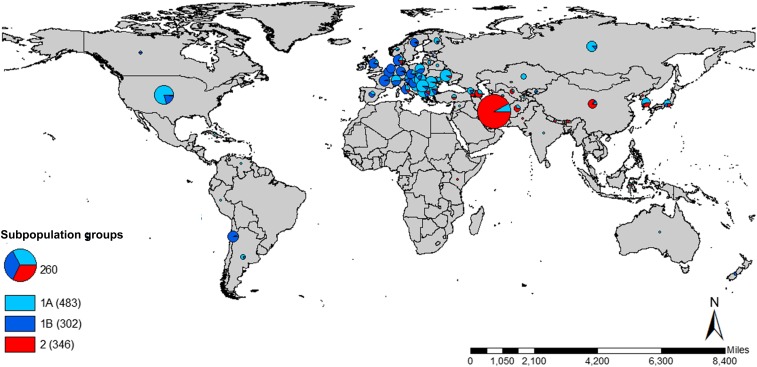
Country-specific distribution of population structure subgroups of the global winter wheat germplasm collection. Only 1131 accessions were assigned to individual countries. The 44 unassigned accessions are from the former Union of the Soviet Socialist Republic (USSR), Yugoslavia, Czechoslovakia, and other unknown parts of Europe.